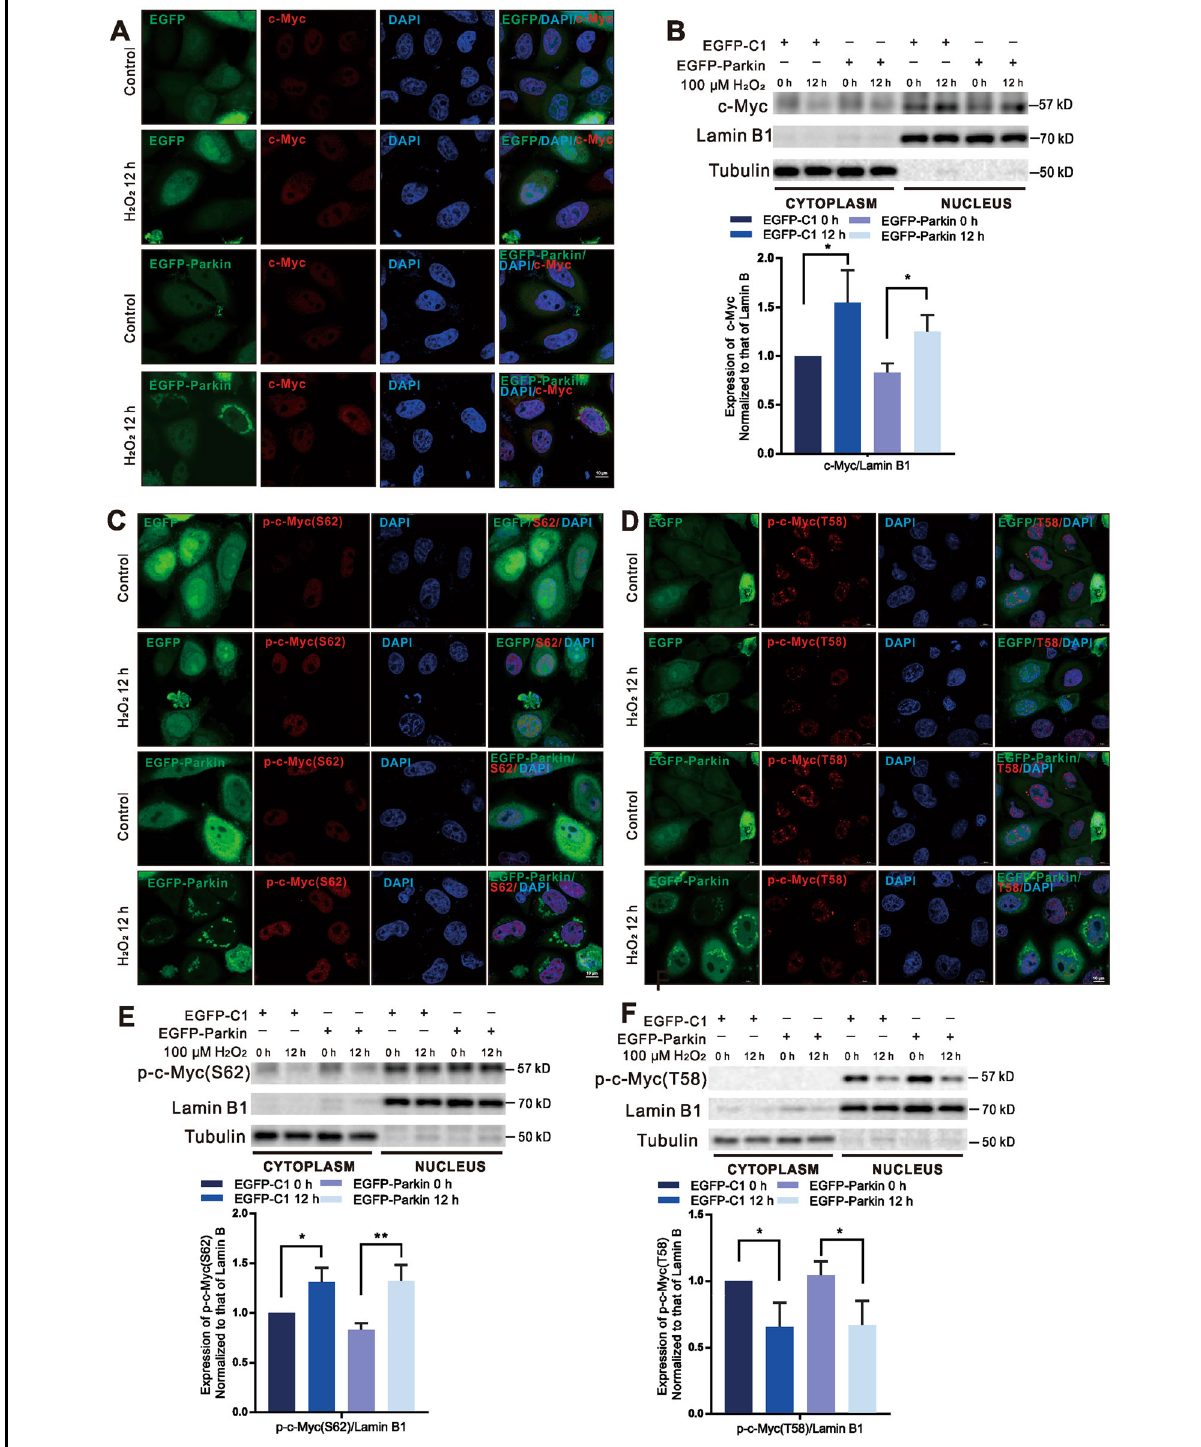
Fig. 4 c-Myc is upregulated in H 2 O 2 -induced cells. A, C, D EGFP-Parkin-transfected and EGFP-C1-transfected HeLa cells were stimulated with 100 μΜ H 2 O 2 for 0 h or 12 h and stained with anti-Myc, anti-Myc-S 62 , and anti-Myc-T 58 antibodies (red). Scale bars, 10 μ m. B , E , F Cells were transfected with EGFP-C1 or EGFP-Parkin plasmids. After 24 h, the cells were treated with 100 μΜ H 2 O 2 for 0 h or 12 h. Nuclear extracts were immunoblotted for c-Myc, p-c-Myc-S62, and p-c-Myc-T58. Lamin B1 was used as a nuclear internal reference, and Tubulin was used as a cytoplasmic internal reference. N = 3; * P < 0.05; ** P < 0.01. The data are from three independent tests and are presented as the mean ±